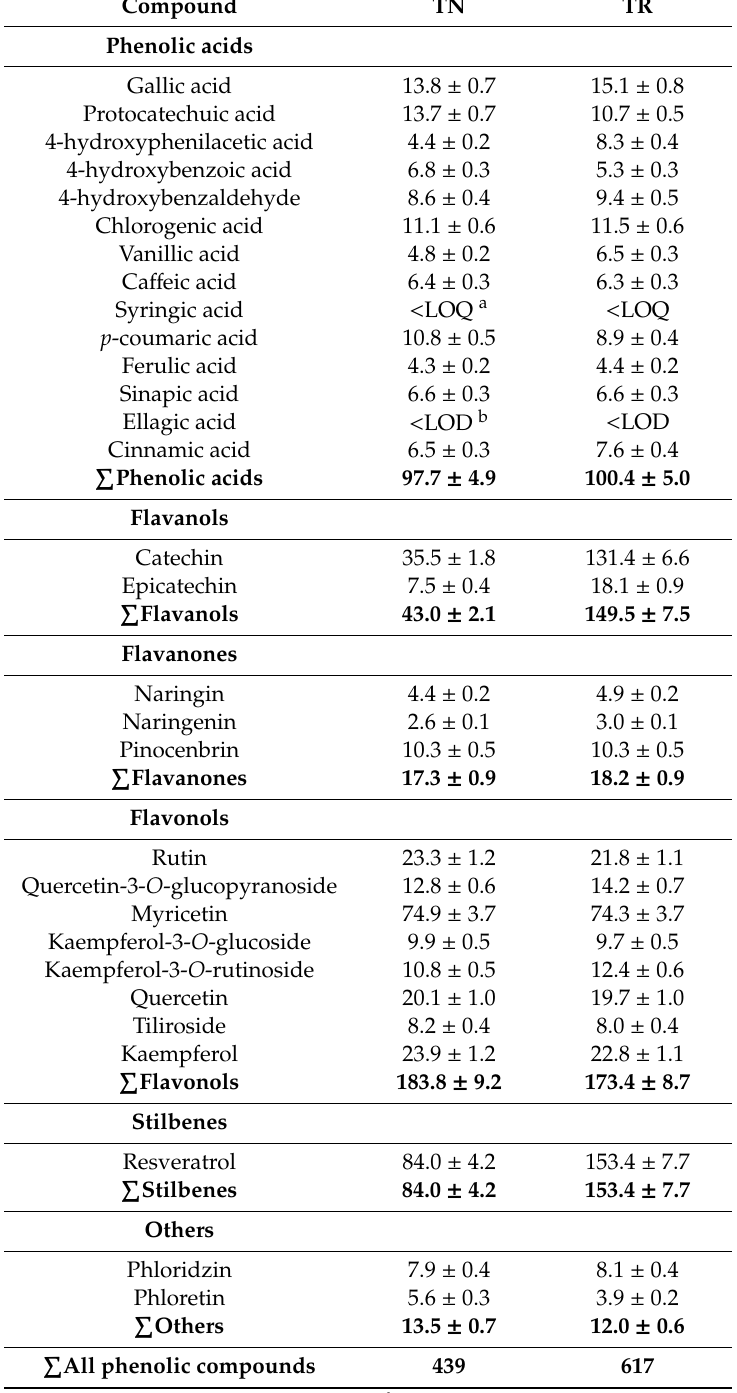
Table 2. Content of the identified phenolic compounds in Touriga Nacional (TN) and Tinta Roriz (TR) extracts obtained by ultrasound assisted extraction (UAE) performed at lab scale without an ice bath after 60 min of extraction; results are expressed as mean ± standard deviation (mg of compound / 100 g DW, n =